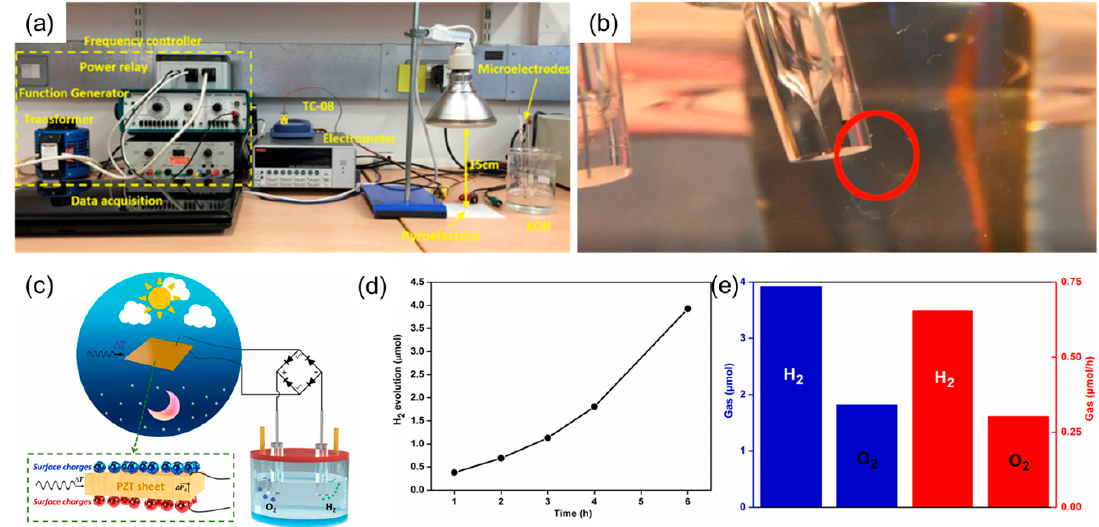
Figure 8. ( a ) Experimental setup for splitting of water using pyroelectrics. ( b ) Continuous hydrogen bubble production during thermal cycling. ( c ) Schematic of externally positioned pyro-electrolysis (EPP) pyroelectric energy harvesting for water splitting. ( d ) H 2 evolution from the EPP pyroelectric water splitting. ( e ) The amount and evolution rate of H 2 and O 2 gases attained for 6 hours. ( a – b ) Reproduced from [9], Copyright 2017, Elsevier. ( c – e ) Reproduced from [78], Copyright 2017, Elsevier.